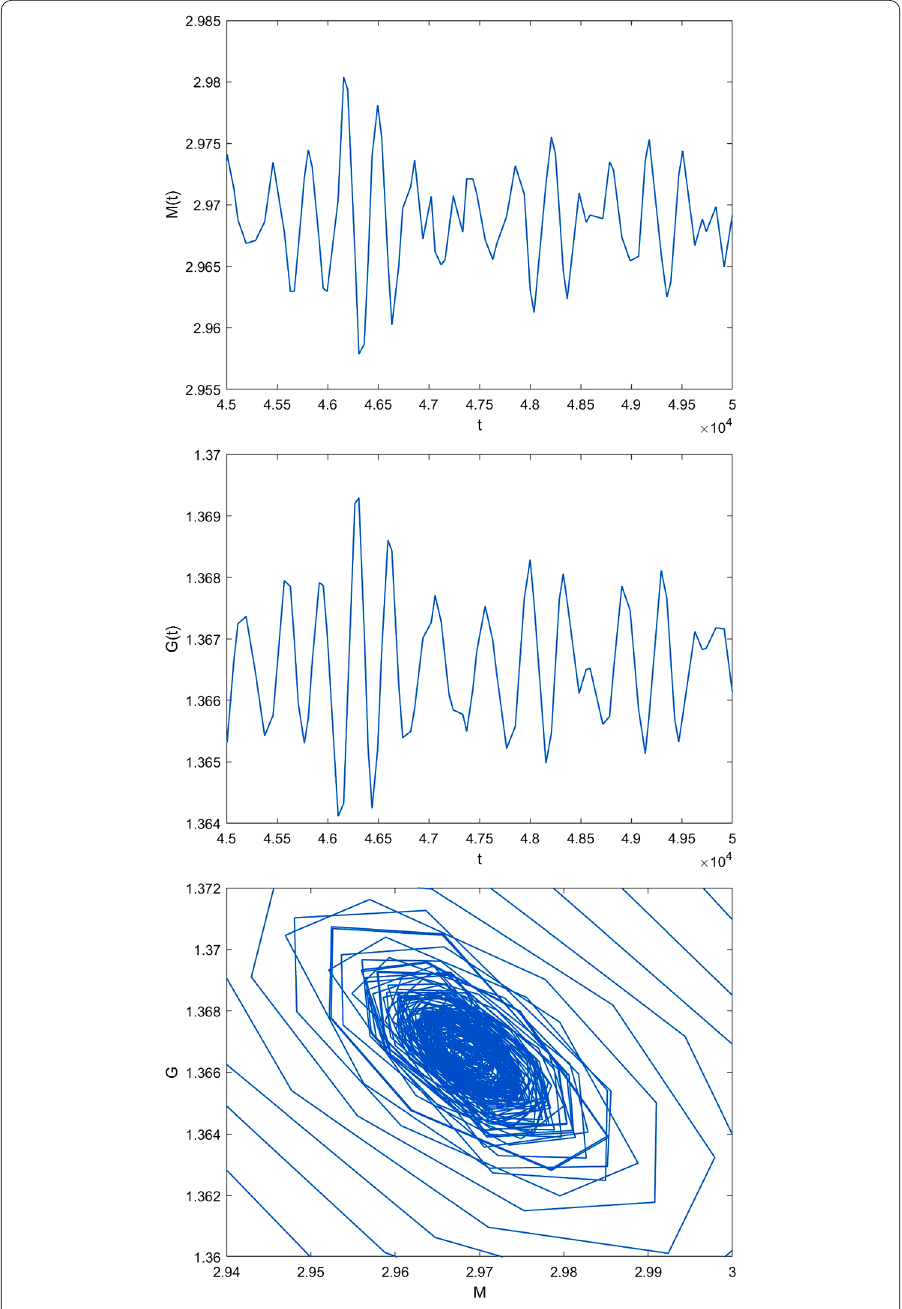
Figure 7 A computer simulation of the system (2.1)–(2.2) with a 1 = 0.1450, a 2 = 0.6937, b 1 = 0.0596, b 2 = 0.0206, α 1 = 0.16385, k 1 = 15.64, k 2 = 12.4113, τ = 39, where M (0) = 5 and G (0) = 0.1. The solution trajectory exhibits chaotic behavior